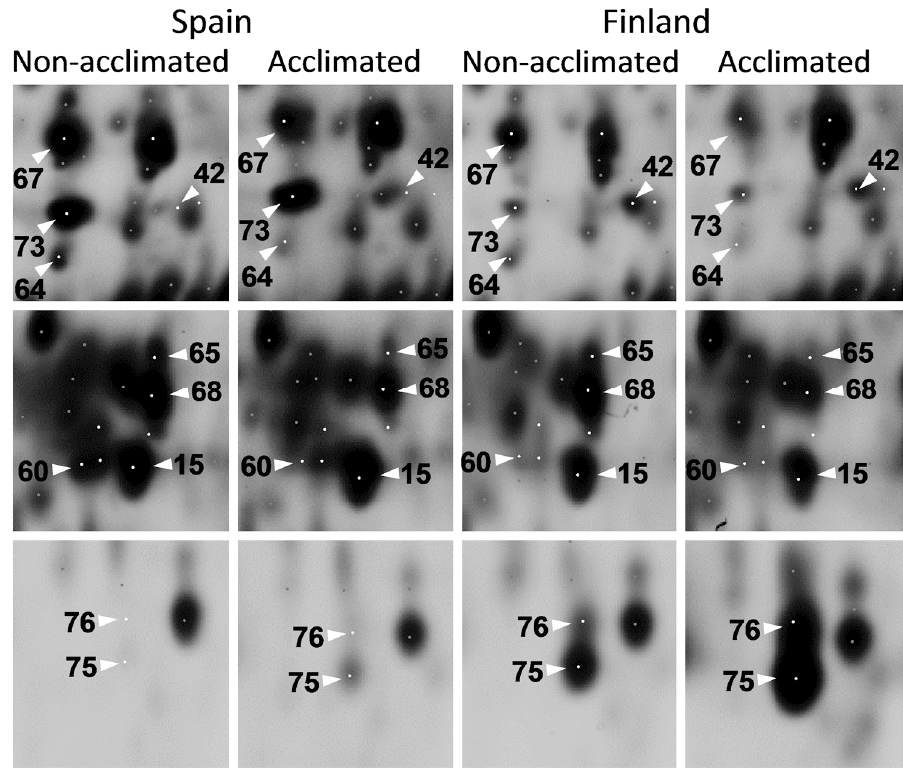
Figure 3. Quantitative differences in protein abundance between non-aclimated and acclimated Scots pine seedlings originating from the geographically separated populations. Representative images of ten identified spots are shown. Complete gel image is presented in Figure S1.